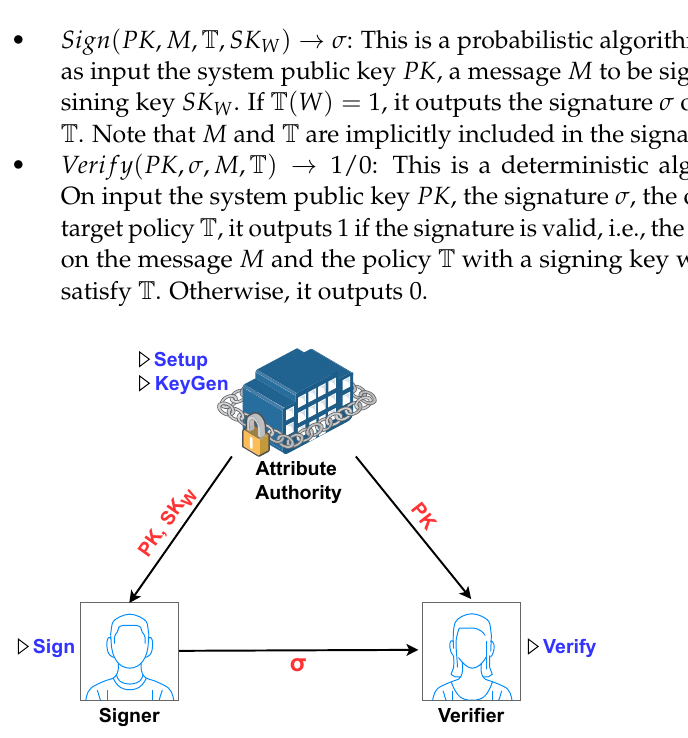
Figure 1. System roles and algorithms of